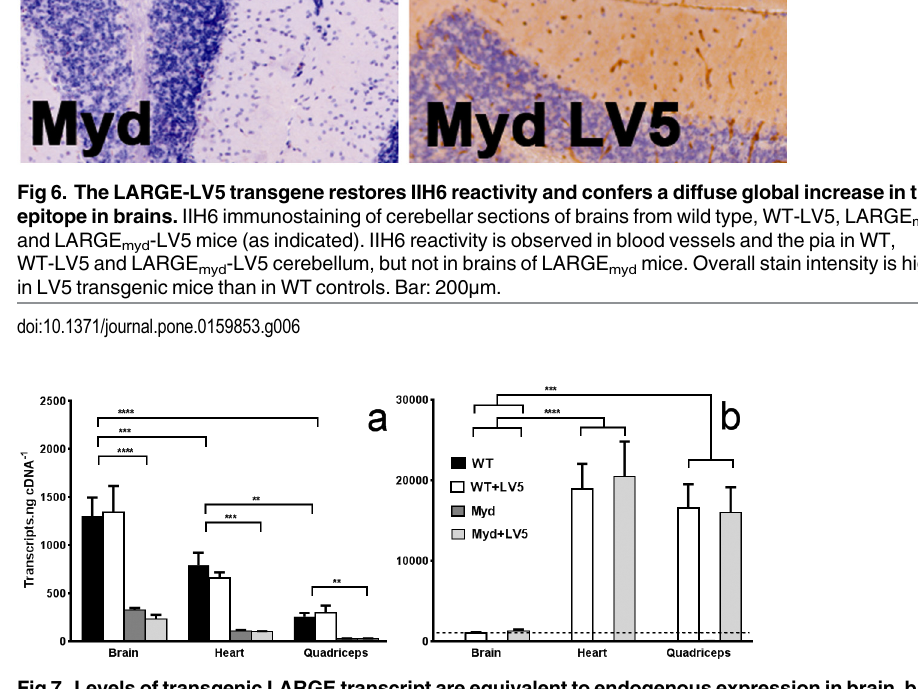
Fig 7. Levels of transgenic LARGE transcript are equivalent to endogenous expression in brain, but greatly overexpressed in heart and skeletal muscle. qPCR analysis of cDNA prepared from brain, heart and quadriceps (from genotypes as indicated) using primers for endogenous LARGE (a) or the LARGE-LV5 transgene (b). Quantities are shown as mean number of transcripts per ng cDNA (+ S.E.M, N = 5 – 9). Dashed line in (b): expression level of endogenous LARGE in brain. ** P < 0.01, *** P < 0.005, **** P < 0.001. No significant differences in endogenous expression within a given tissue were detected between WT and WT-LV5, or in transgene expression between WT-LV5 and LARGE myd -LV5, for any of the tissues studied.